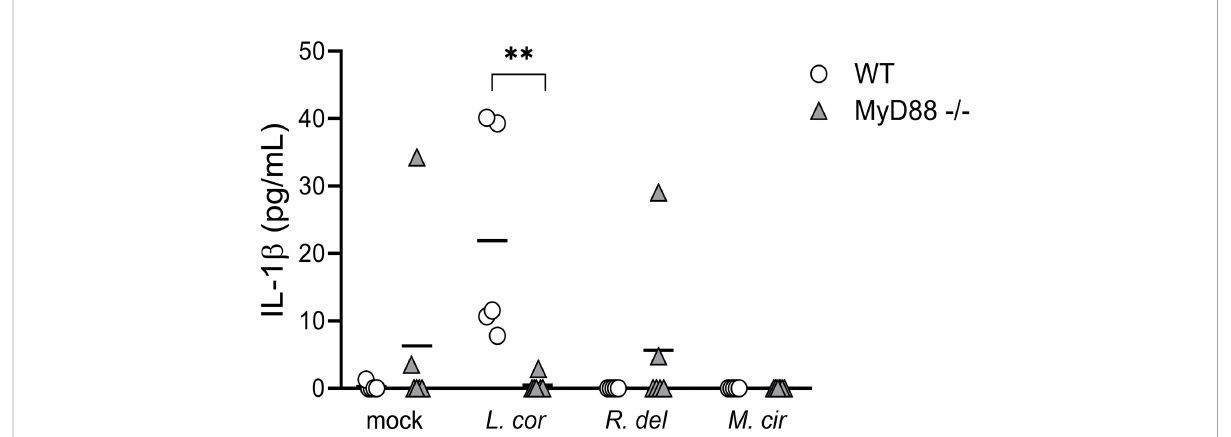
FIGURE 5 Bone marrow-derived monocytes (BMDM) from MyD88 -/- mice failed to induce IL-1 b release in response to L corymbifera. BMDM lacking the adaptor molecule MyD88 were incubated with the mucoralean fungi for sixteen hours. Subsequently, the production of IL-1 b was quanti fi ed by ELISA. Lines represent the mean of data obtained in two independent experiments, each with three different mice, which are represented with symbols. Differences among groups were assessed by Krustal-Wallis as non-normally distributed data. ** p